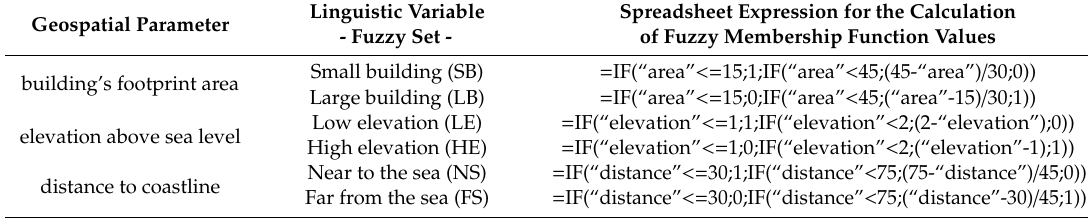
Table 3. Fuzzy sets and membership functions for the key geospatial parameters.